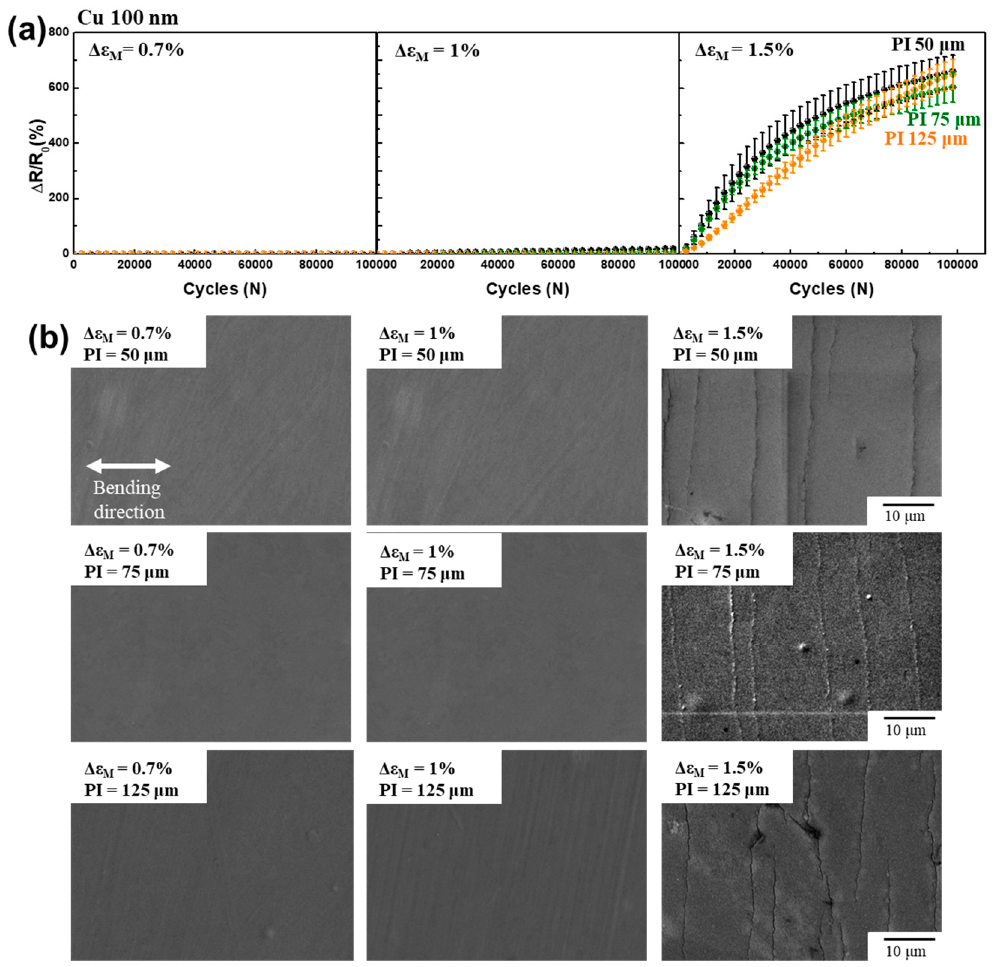
Figure 2. ( a ) Normalized electrical resistance changes of 100 nm thick Cu film on 50, 75, and 125 µm thick polyimide (PI) as a function of the number of bending cycles under bending strain amplitudes of 0.7%, 1%, and 1.5%. ( b ) SEM images of 100 nm thick Cu film after the bending fatigue test.